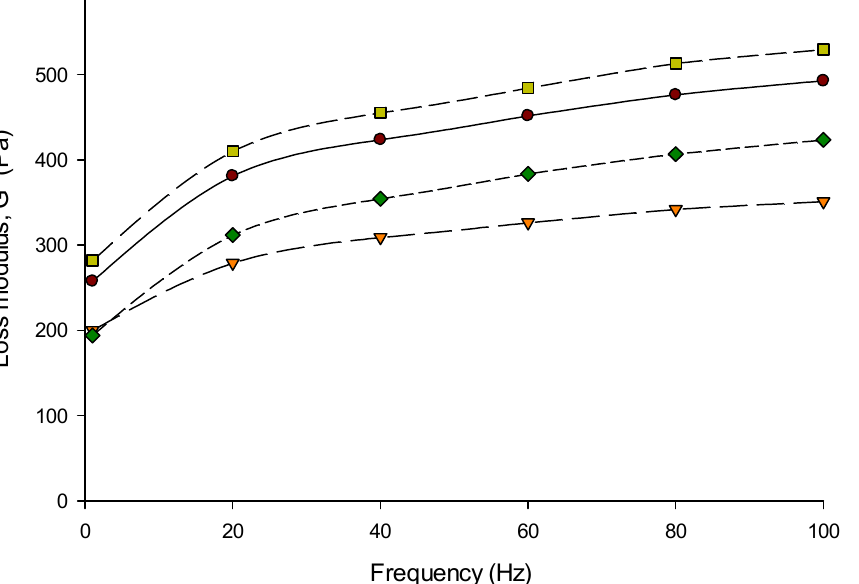
Figure 3. Viscous modulus (G ′′ : Pa) of Feta-type cheese made from micellar casein concentrate (MCC). Treatment: Control ( ● ) = Feta-type cheese made from whole milk; MCC-3 ( ▼ ) = Feta-type cheese made from MCC solution with 3% protein; MCC-6 ( ■ ) = Feta-type cheese made from MCC solution with 6% protein; MCC-9 ( ♦ ) = Feta-type cheese made from MCC solution with 9% protein measured at a range of 0.1 to 100 Hz frequency at 20 °C using dynamic rheological analysis (DSR).